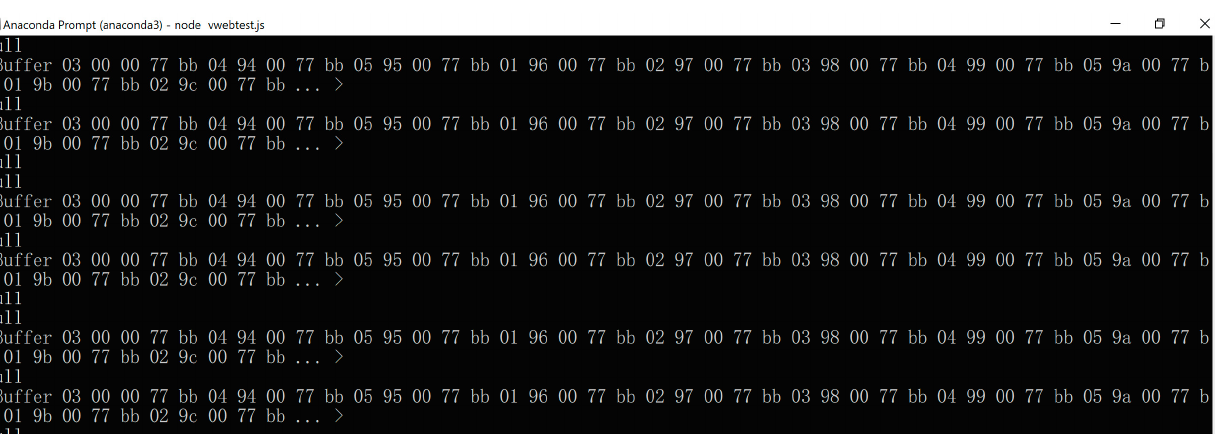
Figure 8. Broadcasting data on Node.js vital-sign web server.